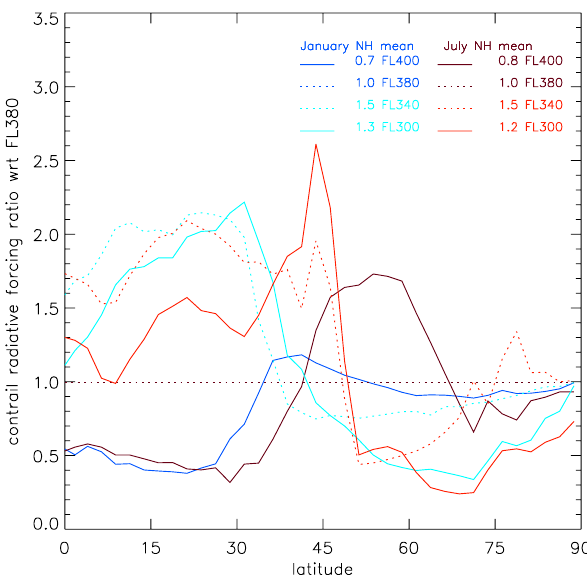
Fig. 7. January and July zonal contrail net radiative forcing for mean, upper standard deviation (+sd), and lower standard deviation (-sd) IWC assumptions at FL380 and 1000 m vertical depth. The numbers show the global